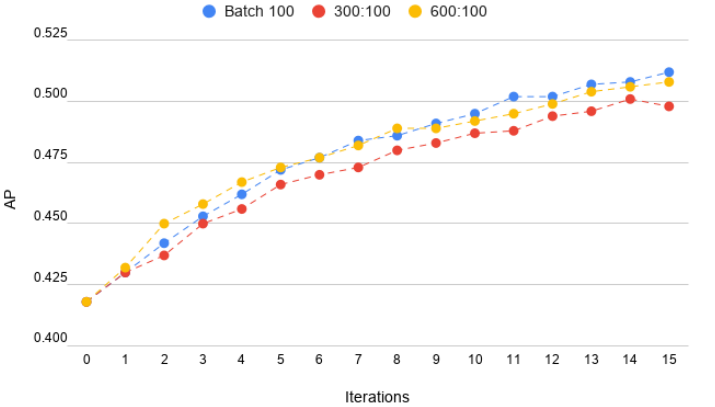
Figure 11. AP for batch 100, 300:100, and 600:100 networks.